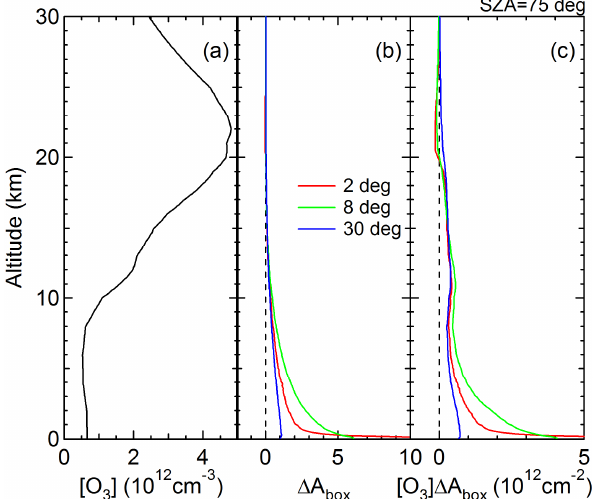
Fig. 3. Vertical profiles of (a) the number density of ozone ([O 3 ]) taken from the US Standard Atmosphere, (b) the differential box air mass factor ( 1A box ) , and (c) [O 3 ] 1A box at SZA=75 ◦ . Red, green, and blue represent elevation angles of 2 ◦ , 8 ◦ , and 30 ◦ , respectively. Values are plotted for each 100m. The relative viewing azimuth angle with respect to the Sun is assumed to be 180 ◦